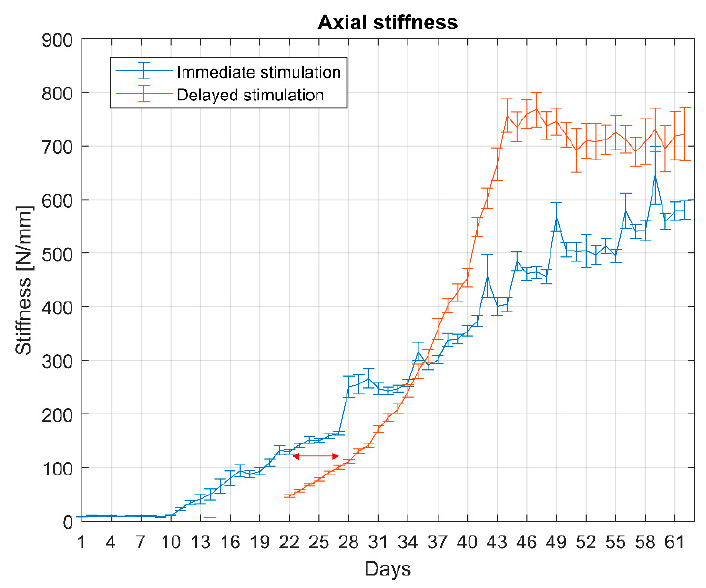
Figure 7. Measurements of the in vivo stiffness show that the delayed stimulated fracture consolidates approximately one week later as compared to the immediately stimulated (arrow). The daily results are presented as the average of all 1000 daily measurements and the bars represent standard deviation. An additional measurement (10 loading cycles) was performed on the animal with delayed stimulation on day 14 to acquire a baseline value of the fracture